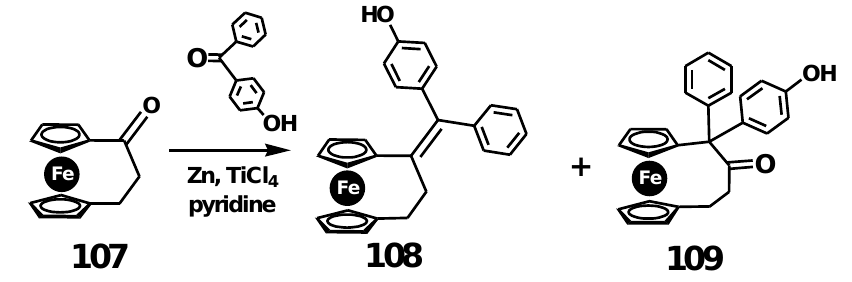
Scheme 35. Pinacol rearrangement of a